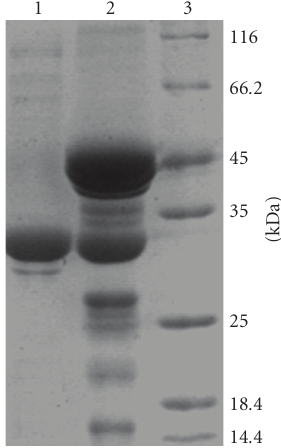
Figure 3: SDS-PAGE electrophoresis of red kidney bean lectin. Lane 1: purified red kidney bean lectin. Lane 2: crude red kidney bean lectin. Lane 3: molecular mass standards. From top downwards: β - galactosidase (116.0 kDa), bovine serum albumin (66.2 kDa), oval- bumin (45.0kDa), lactate dehydrogenase (35.0kDa), REase Bsp981 (25.0kDa), β -lactoglobulin (18.4kDa), and lysozyme